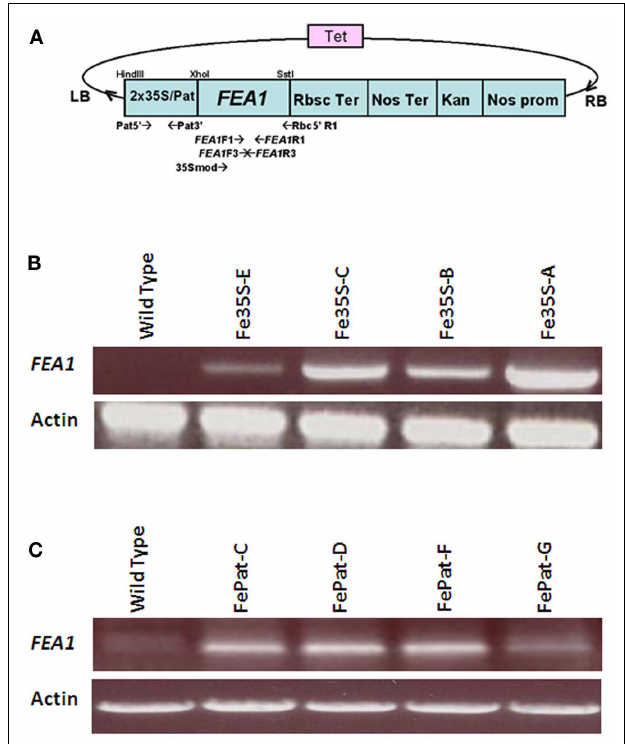
FIGURE 3 | RT-PCR analysis of expression in FEA1 transgenic plants. (A) Modified pKYLX– FEA1 vector used for transformation of wild-type Arabidopsis thaliana .Two separate plasmids were used for transforming plants with the FEA1 gene driven by the 35S promoter (constitutive) and patatin (storage organ) promoter. (B) RT-PCR analysis of FEA1 expression in leaves of independent 2 × 35S –FEA1 transgenic plants. (C) RT-PCR analysis of FEA1 expression in roots of independent patatin- FEA1 transgenic